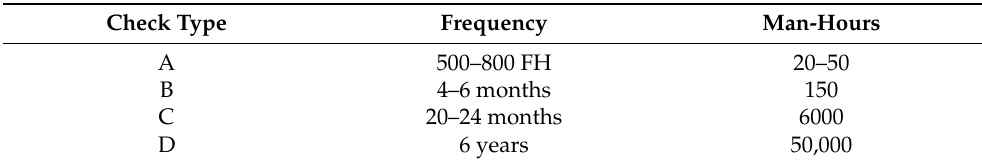
Table 9. Scheduled maintenance levels for commercial aircraft [159].